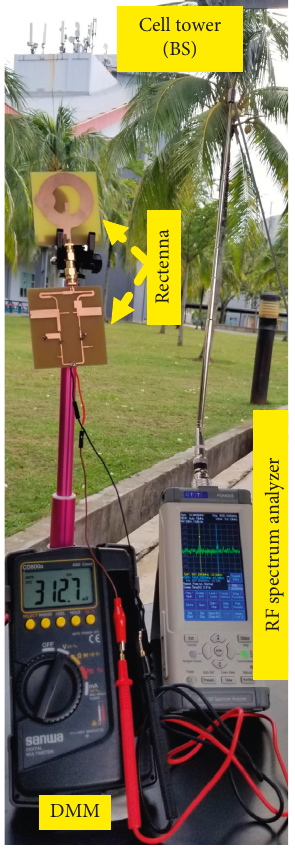
Figure 8: Ambiance measurement setups of the proposed